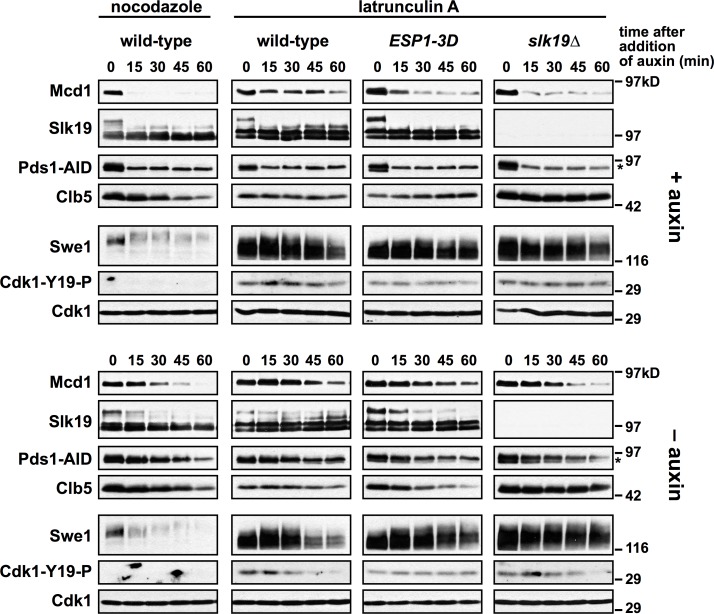
ESP1-3D and slk19Δ bypass a Pds1-independent arrest.The indicated strains were grown to log phase, arrested in G1 with α-factor, and released from the arrest into media containing nocodazole or latrunculin A at 25°C. After 2 h (t = 0), +/- auxin was added to the cultures. Samples were harvested for immunoblotting at the indicated timepoints, run on a polyacrylamide gel, and immunoblotted with the indicated antibodies. cdc55Δ was not analyzed in this experiment because it is defective in both the spindle assembly and morphogenesis checkpoints, and does not arrest in nocodazole or LatA. Pds1-AID migrates adjacent to a background band (indicated by an *).